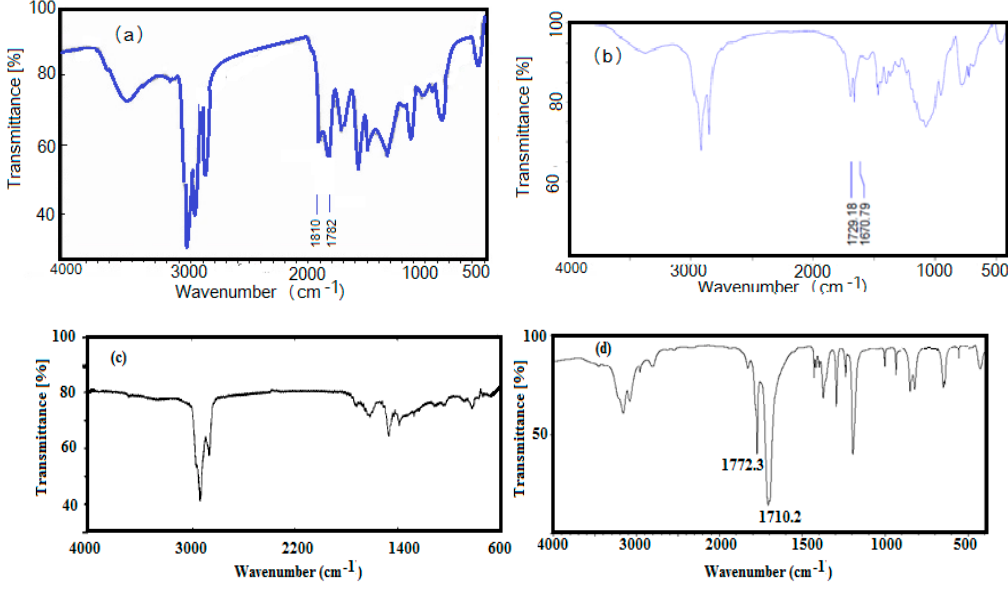
Figure 1. FTIR spectra of ( a ) Asphaltene-maleic anhydride, ( b ) ASAS, ( c ) asphaltene, and ( d ) succinimide.